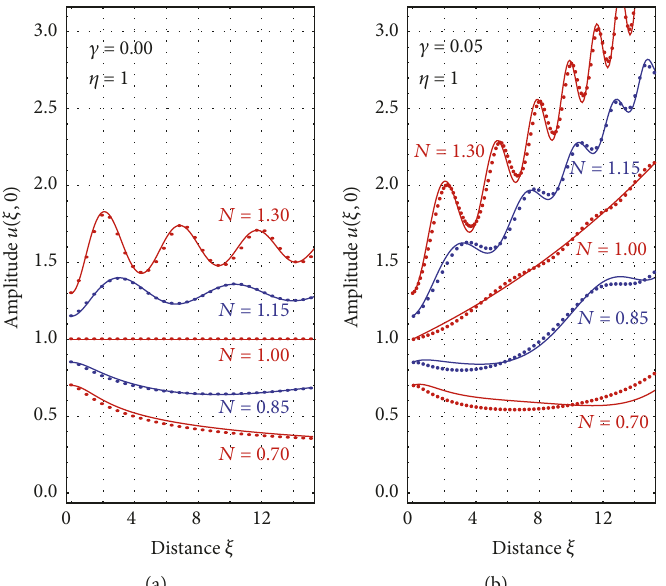
Figure 7: (a) Evolution of pulse amplitude from model (solid curve) and numerics (dots) for initial values of 𝑁 = 0.7,. .. ,1.3 . (b) Same propagation with included gain ( 𝛾 = 0.05 , 𝜖 = 0.03